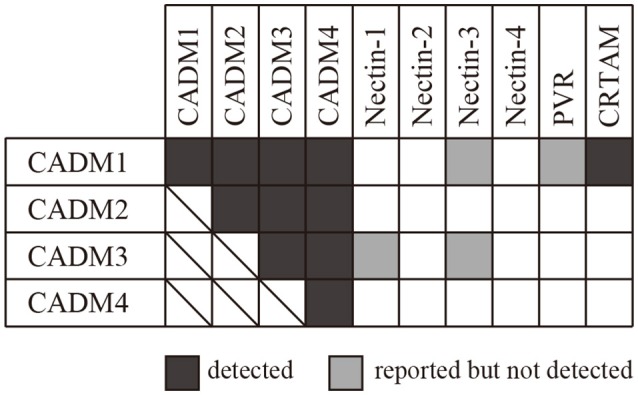
Combination of the interactions between the CADM family proteins and the 10 IgSF molecules including the CADM and the Nectin family proteins. The interactions detected by SPRi are shown in black and those reported but not detected by SPRi are shown in gray.